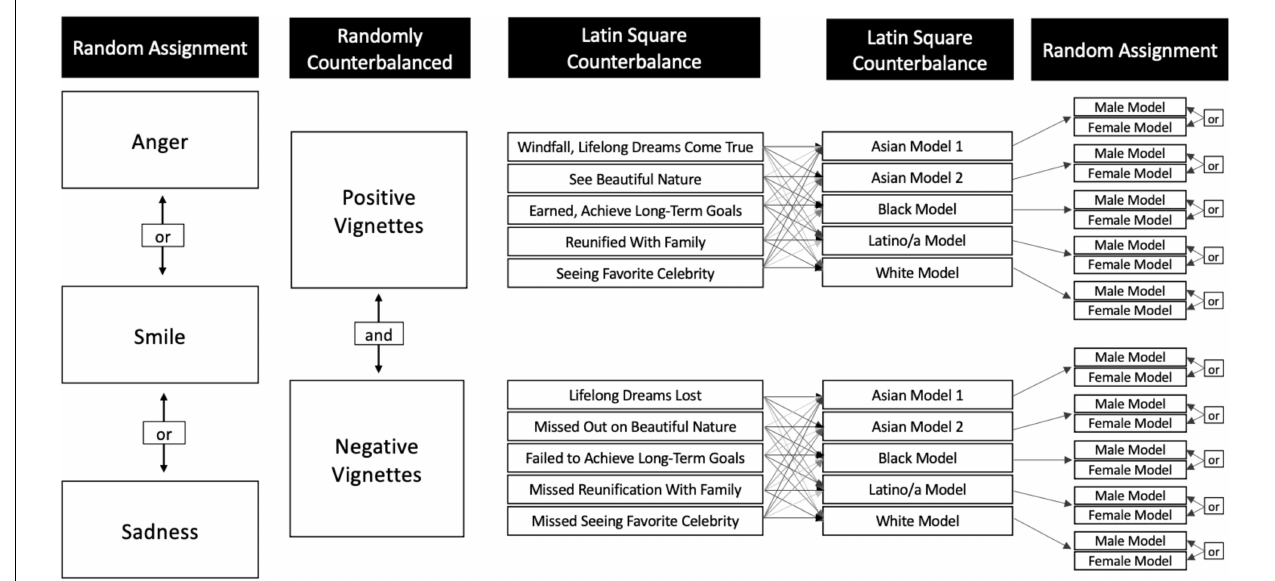
FIGURE 1 | In the experimental portion, participants were assigned randomly to view models with either an anger, smiling, or sadness expression. Counterbalancing ensured that all participants responded to five positive and five negative vignettes, with Asian, Black, Latino/a, and White models, that were either male or female.